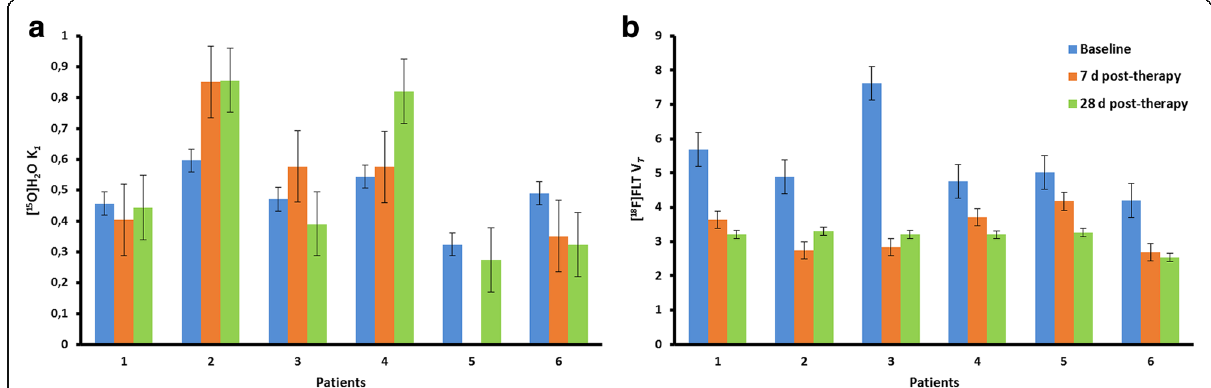
Fig. 1 Average TBF ( a ) and [ 18 F]FLT V T ( b ) values for all the patients across the three time points: baseline, 7 days post-therapy and 28 days post-therapy. The error bars represent standard error